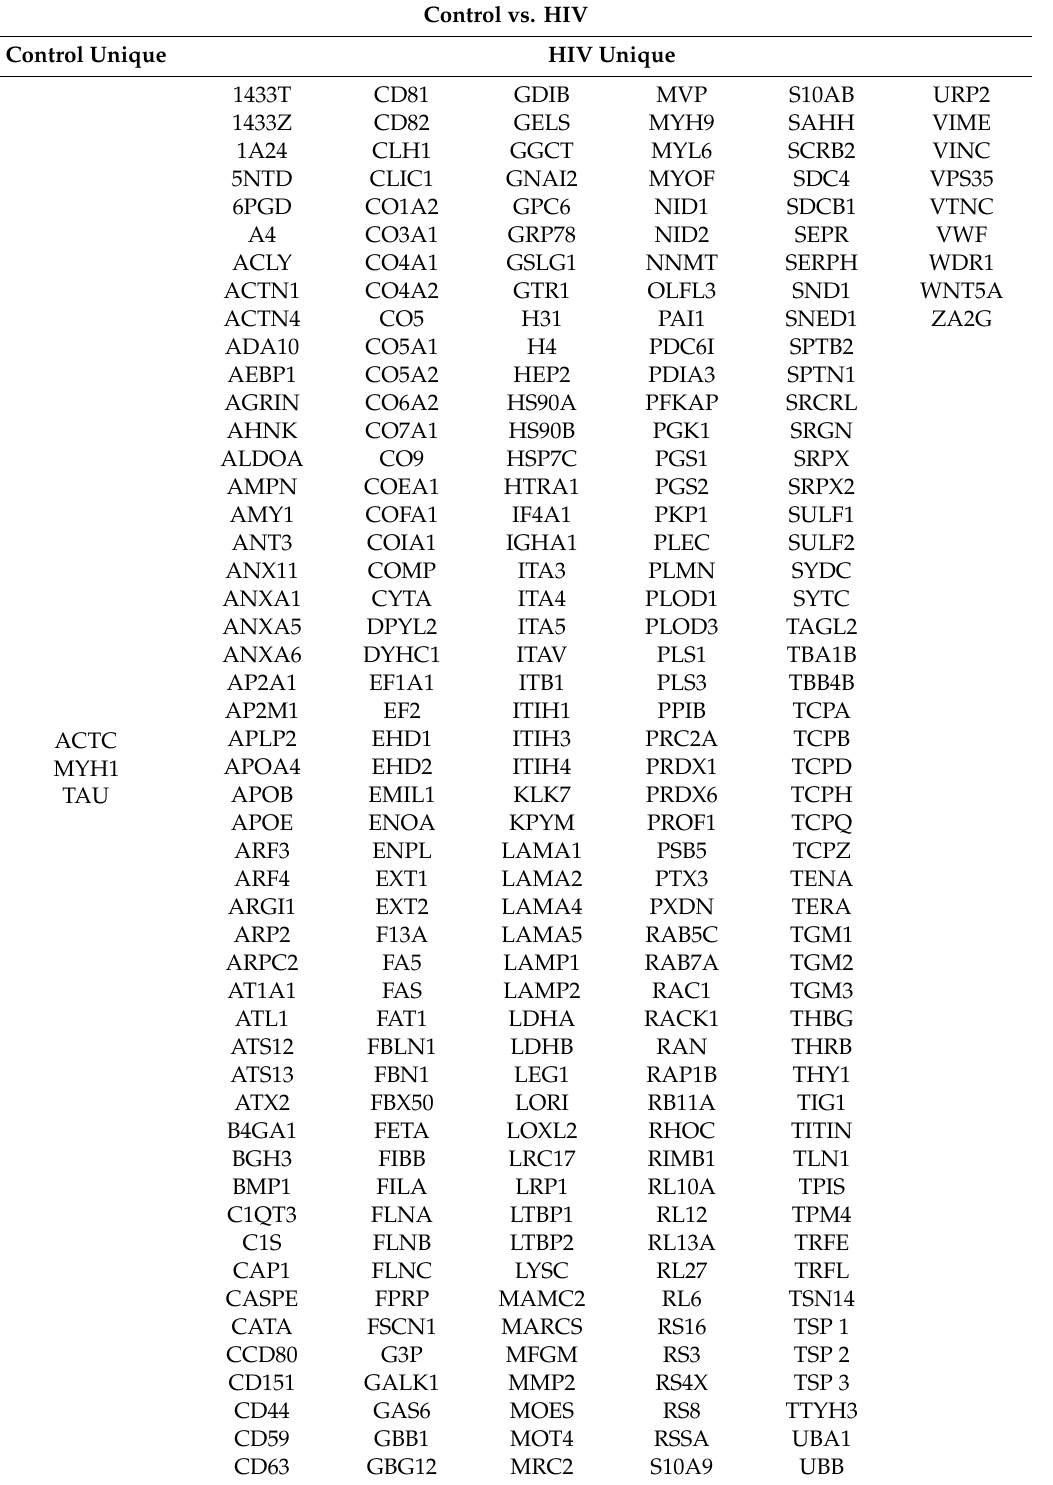
Table 3. List of the unique proteins in the EV total